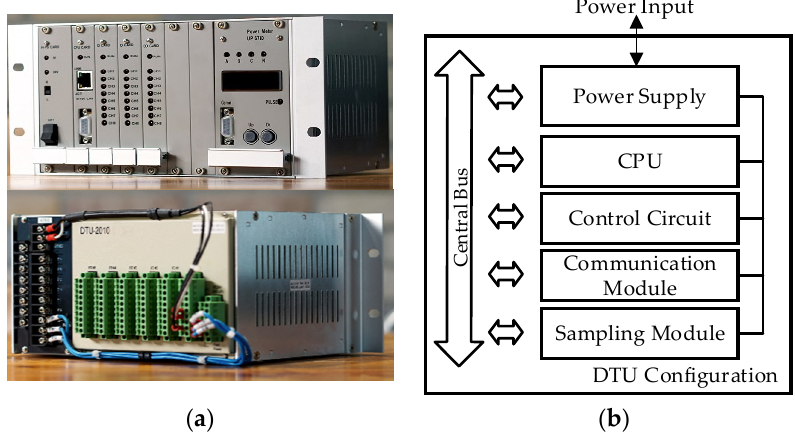
Figure 2. ( a ) Picture of DTU; ( b ) configuration of DTU.